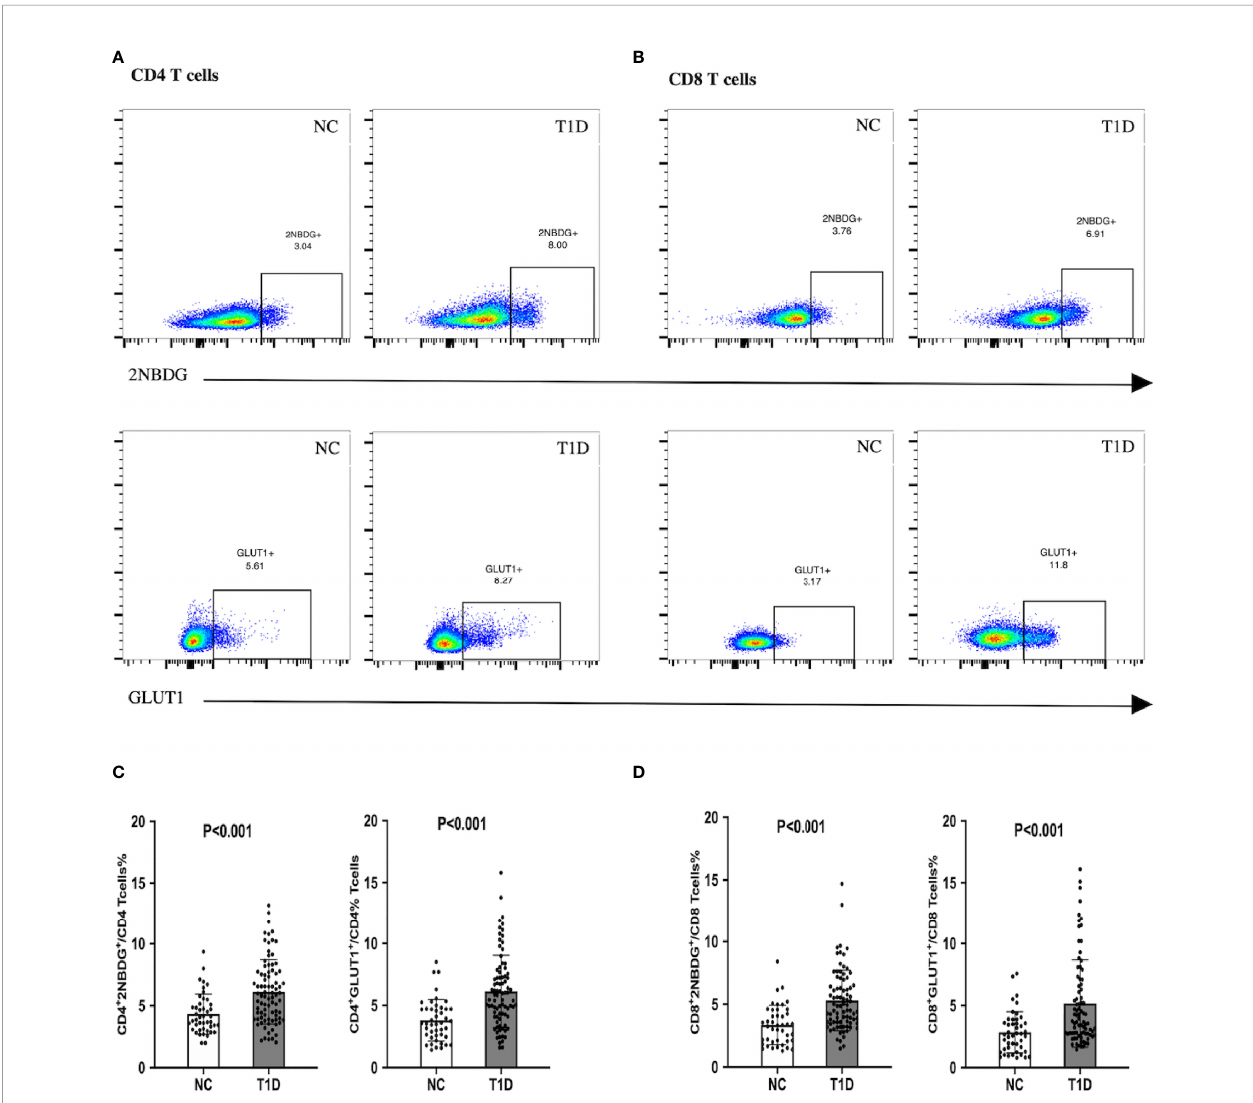
FIGURE 1 | Glucose uptake and GLUT1 expression of CD4+/CD8+ T cells in patients with T1D. T1D patients demonstrated enhanced intracellular glucose uptake. (A, C) The proportion of 2NBDG+ and GLUT1+ cells in CD4+ cells. (B, D) The proportion of 2NBDG+ and GLUT1+ cells in CD8+ cells. The bar and error bar = mean and SD. T1D, type 1diabetes; NC, normal control; GLUT1, glucose transporter